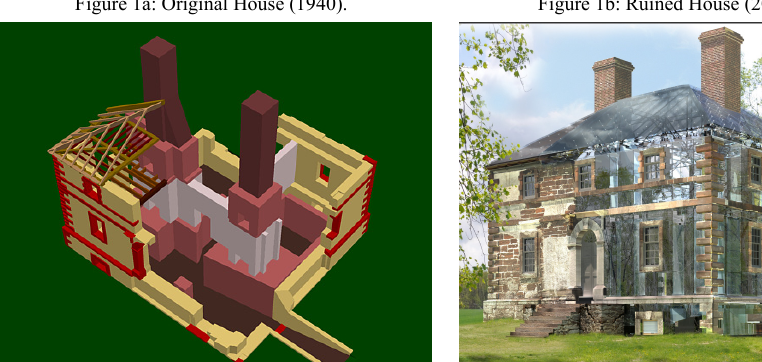
Figure 1a: Original House (1940). Figure 1b: Ruined House (2008).